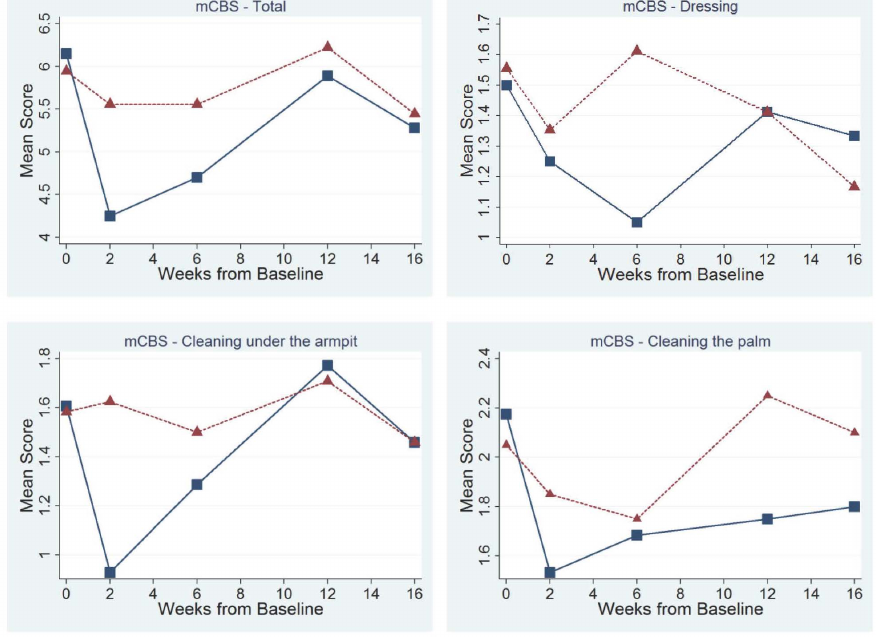
Fig. 2. mCarer Burden Scale (mCBS) in each subject treated with Incobotulinumtoxin A ( % ) and Placebo ( D